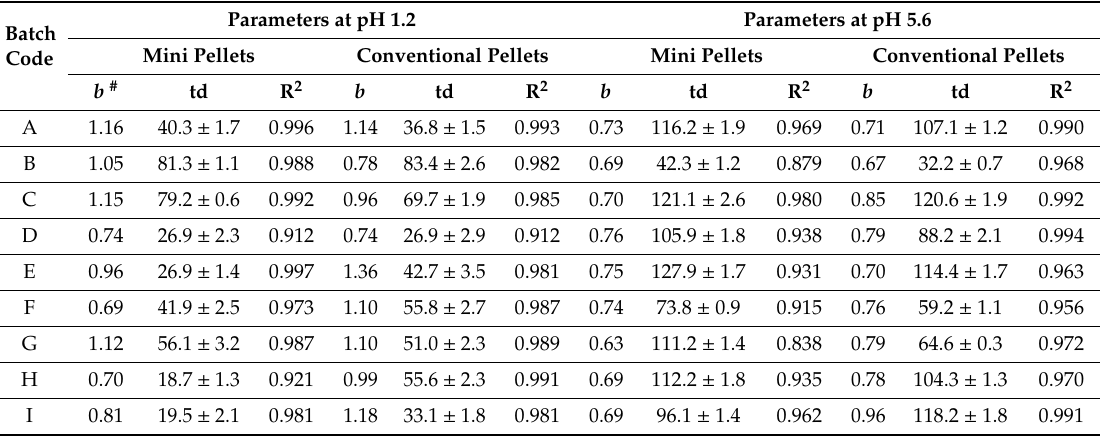
Table 8. Weibull equation parameters (mean ± SD, n = 3) for the dissolution of mini and conventional pellets at pH 1.2 and